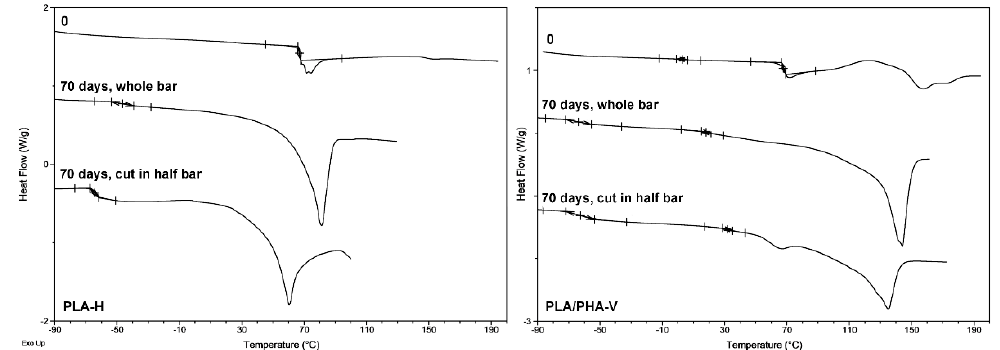
Figure 4. Selected differential scanning calorimetry (DSC) curves (first heating run) for the PLA dumbbell-shaped specimen obtained by 3D printing in horizontal (H) direction ( left ) and PLA/PHA dumbbell-shaped specimen obtained by 3D printing in vertical (V) direction ( right ) before (0) and after 70 days of hydrolytic degradation of whole and cut in half specimens.